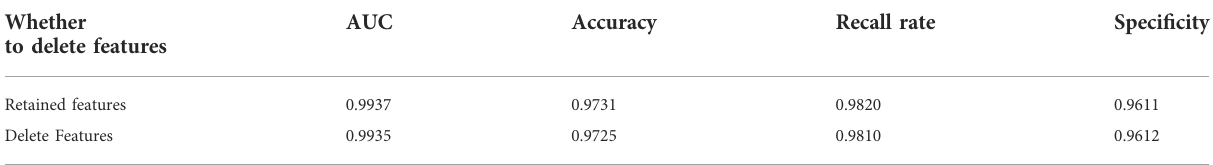
TABLE 3 The compare of whether to retain Strongly relevant features ’ classi fi cation model. Whether to delete